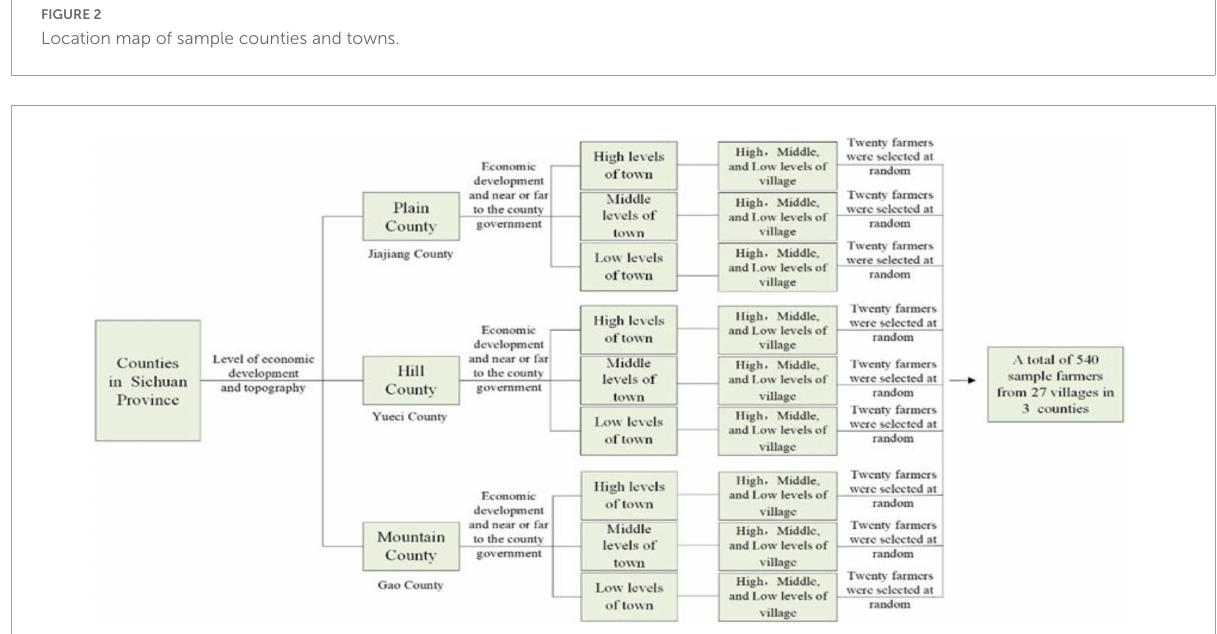
FIGURE2 Location map of sample counties and towns.